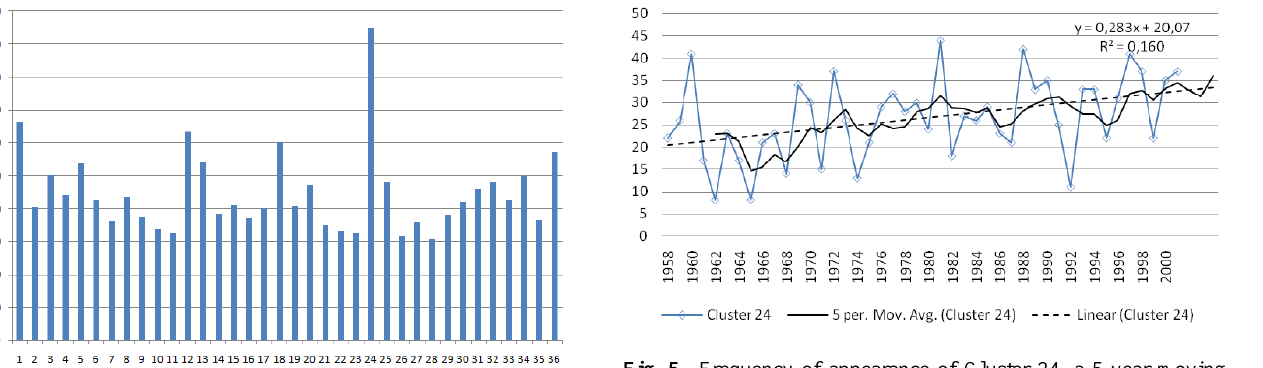
Fig. 5. Frequency of appearance of Cluster 24, a 5-year moving average and a linear fit.